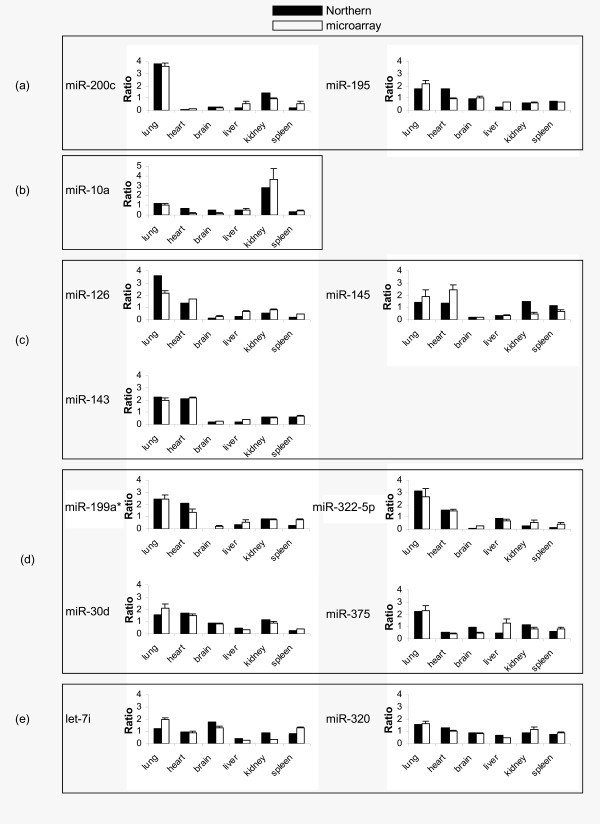
Comparison between results from the microarray and Northern blots. The Northern blots in Figure 4 were quantitated by the Personal Molecular Imager® FX and normalized to U6. Y axes represent the normalized intensities in the Northern blots or the normalized ratios in the microarrays divided by the average of those from 6 organs. The microarray data shown are means ± S.E. from 8 hybridizations. (a) lung-specific miRNAs; (b) kidney-specific miRNAs; (c) co-expressed miRNAs in the lung and heart identified by HSD; (d) miRNAs highly expressed in the lung and/or the heart. (e) commonly expressed miRNAs.